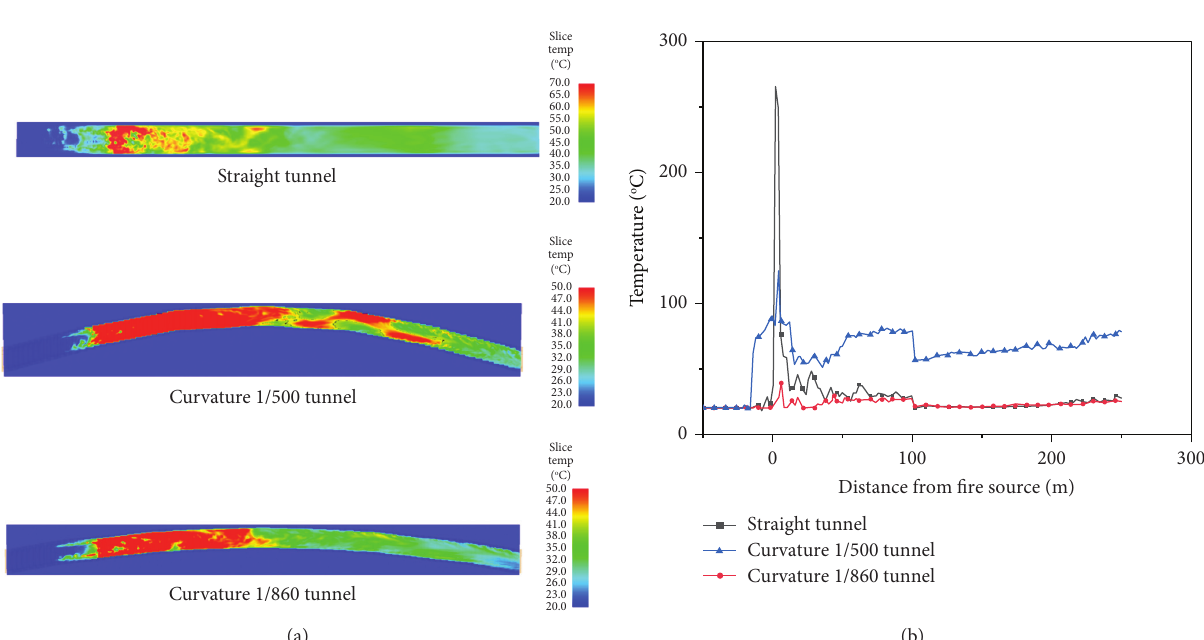
Figure 11: Longitudinal distribution of temperature at eye height. (a) Temperature field at the height of the human eye. (b) Temperature curve at eye height of 2 m/s ventilation